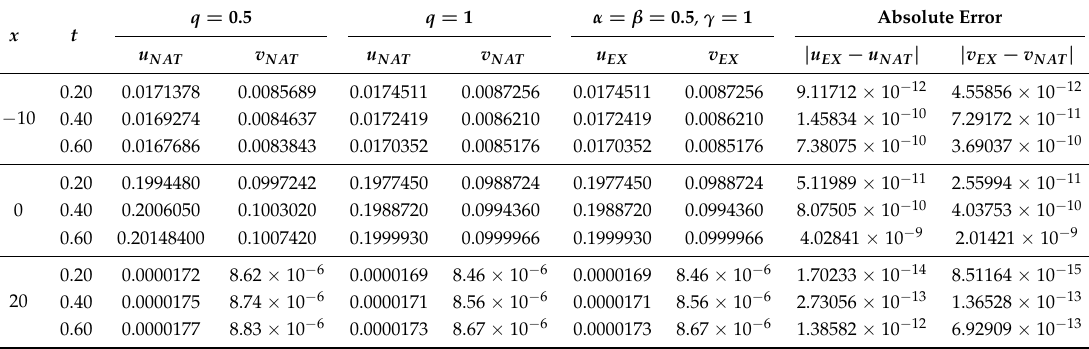
Table 1. Numerical values when q = 0.5,1 and α = β = 0.5, γ = 1 for Example